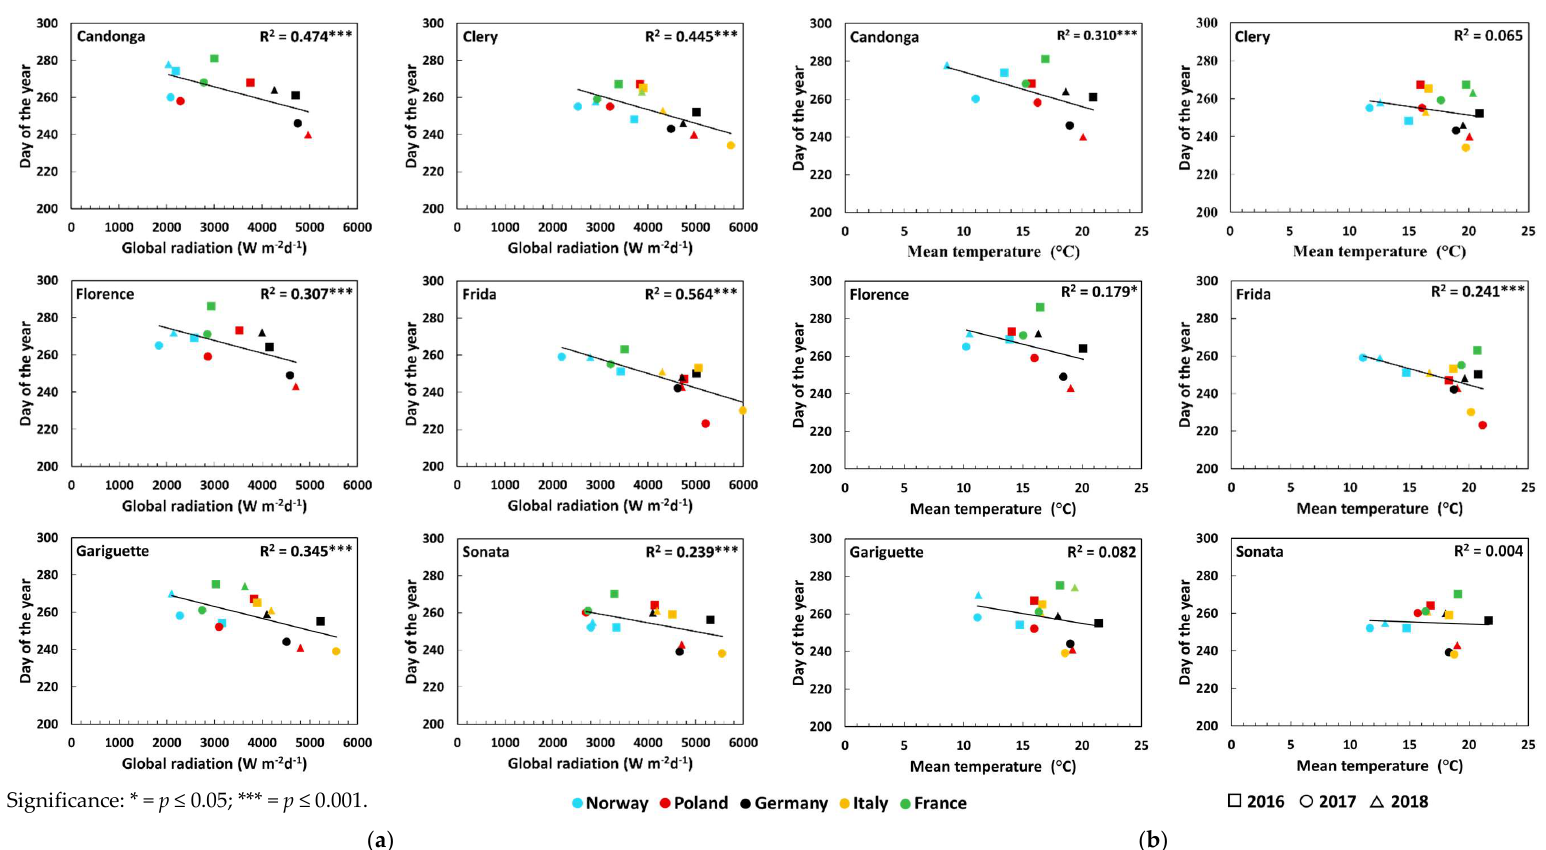
Figure 3. Day of flower initiation (floral developmental Stage 2) for six cultivars as influenced by ( a ) global radiation and ( b ) mean temperature during the 3-week period preceding flower initiation in 3 years.